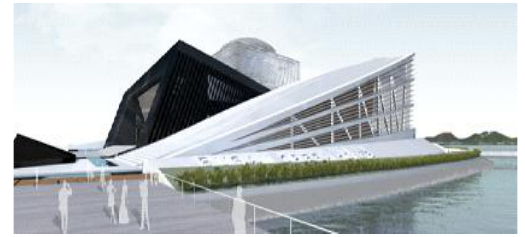
Fig. 8: Opera house (competition). (Greek architects, 2012)